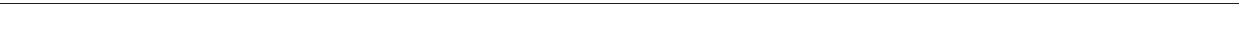
Fig. 4 A multimeric pMHC ligand is required to promote cooperative pMHC binding. a CD8 + OT-1 T cells were preincubated at 0 °C with 100 nM biotinylated OVAp monomer for the indicated times and subsequently incubated with 5 nM of OVAp-APC tetramer for fi ve additional minutes. Time 0 indicates binding of OVAp-APC tetramer in the absence of preincubation with OVAp monomer. Cells were fi xed and stained with streptavidin-PE in order to detect binding of the monomer. Plots represent the MFI values for OVAp-PE monomer and OVAp-APC tetramer binding. b CD8 + OT-1 T cells were incubated at 0 °C with the indicated concentrations of biotinylated OVAp monomer for 6 min and subsequently incubated with 5 nM of OVAp-PE tetramer for 5 additional minutes. Cells were then fi xed and stained with streptavidin-APC in order to detect the monomer. Plots represent the MFI values for OVAp-APC monomer and OVAp-PE tetramer binding. c CD8 + OT-1 T cells were preincubated at 0 °C with 1 nM OVAp-APC tetramer for the indicated times and subsequently incubated with 1.5 μ M of biotinylated OVAp monomer (detected with streptavidin-PE) for 5 additional minutes. Time 0 indicates binding of OVAp monomer in the absence of preincubation with OVAp-APC tetramer. Cells were fi xed and stained with streptavidin-PE in order to detect binding of the monomer. Plots represent the MFI values for OVAp-PE monomer and OVAp-APC tetramer binding. d CD8 + OT-1 T cells were preincubated or not at 0 °C with 1 nM of OVAp-PE tetramer for 6 min prior to incubation with the indicated concentrations of biotinylated OVAp monomer for fi ve additional minutes. Cells were fi xed and stained with streptavidin-APC in order to detect binding of the monomer. Plots represent the MFI values for OVAp-APC monomer and OVAp-PE tetramer binding. All data shown in Fig. 4 represent the mean ± s.d. of triplicate datasets; * p < 0.05; ** p <